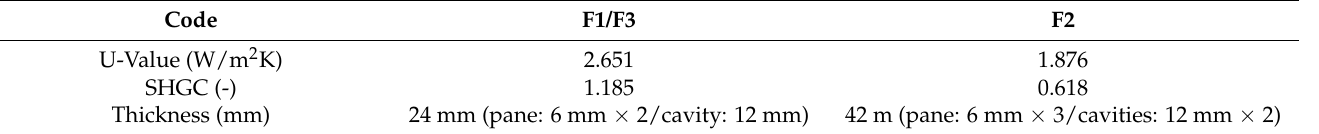
Table 14. Glazing system’s